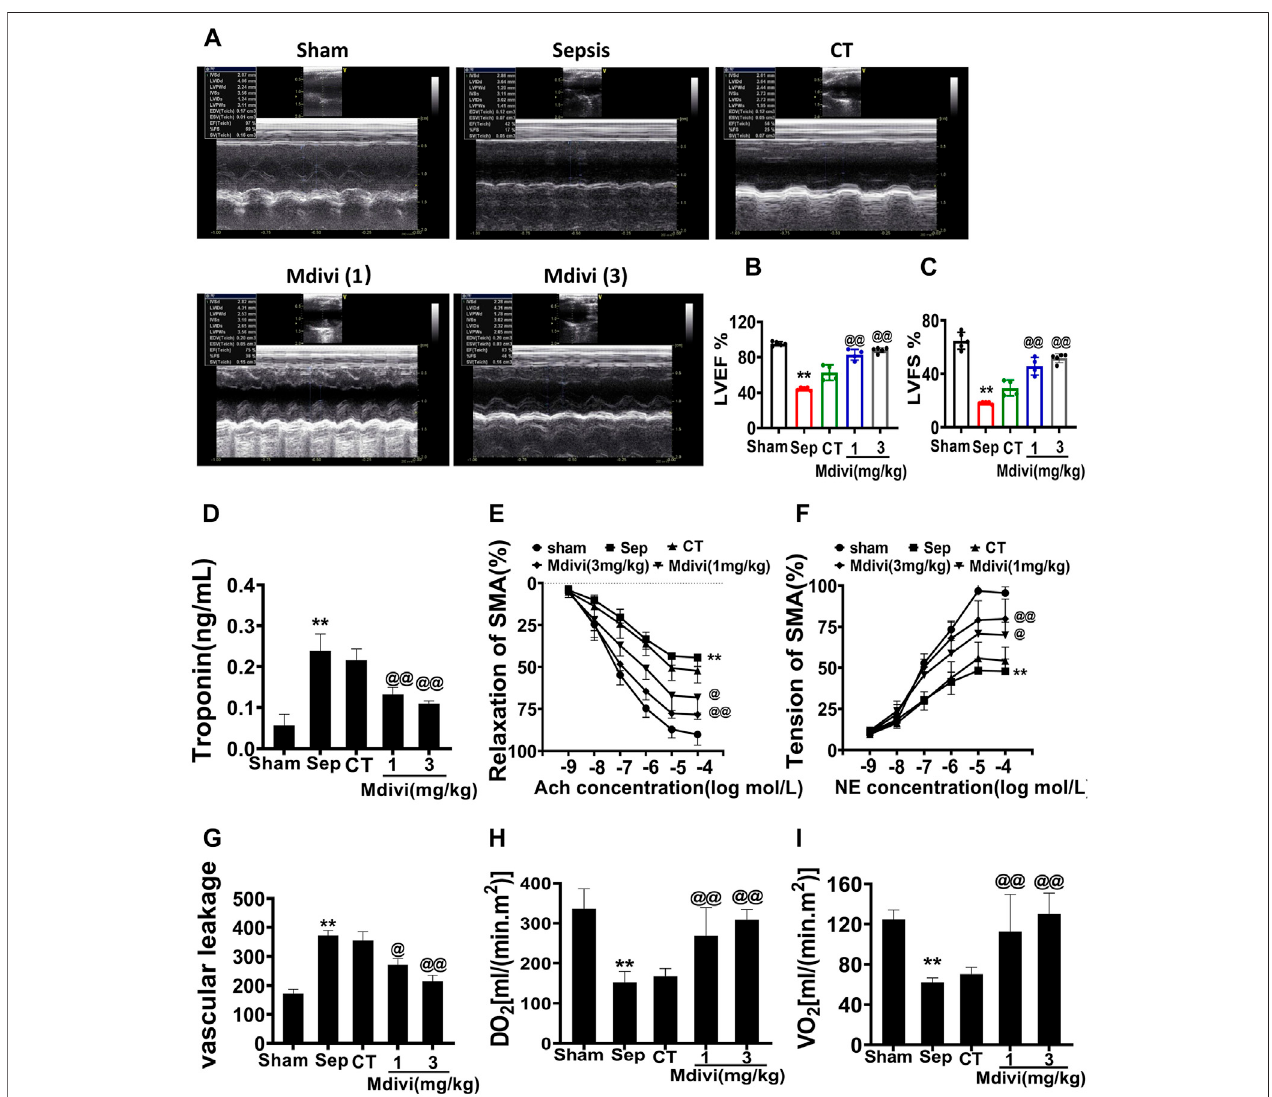
FIGURE 1 | Effects of Mdivi-1 on cardiovascular function in septic rats. (A – D) : Effects of Mdivi-1 on cardiac function in septic rats. (A) : Echocardiograms. (B,C) : Summary ofcardiac EF (B) and FS (C) measured using echocardiography. (D) : Effects of Mdivi-1 on blood troponin level in septic rats, the change oftroponin, amarker ofheartdamage,was detected byblood sampling at thetreatmentpoint. (E,F) :EffectsofMdivi-1 on vascular contractile and relaxation function inseptic rats. SMAwas used to measure the contraction and relaxation responses todifferent concentrations ofNE and Ach. (G) : Effects ofMdivi-1 on vascular leakage in septic rats. The pulmonary vein was taken and labeled with fl uorescent albumin to measure the permeability of fl uorescent albumin. (H) : DO 2 (Oxygen delivery). (I) : VO 2 (oxygen consumption). ** p < 0.01 versus Sham. @ p < 0.05 and @@ p < 0.01 versus CT group. Sham (cid:1) the control group, Sep (cid:1) sepsis, CT (cid:1) conventional treatment. 1: Mdivi-1 (1 mg/kg). 3: Mdivi-1 (3